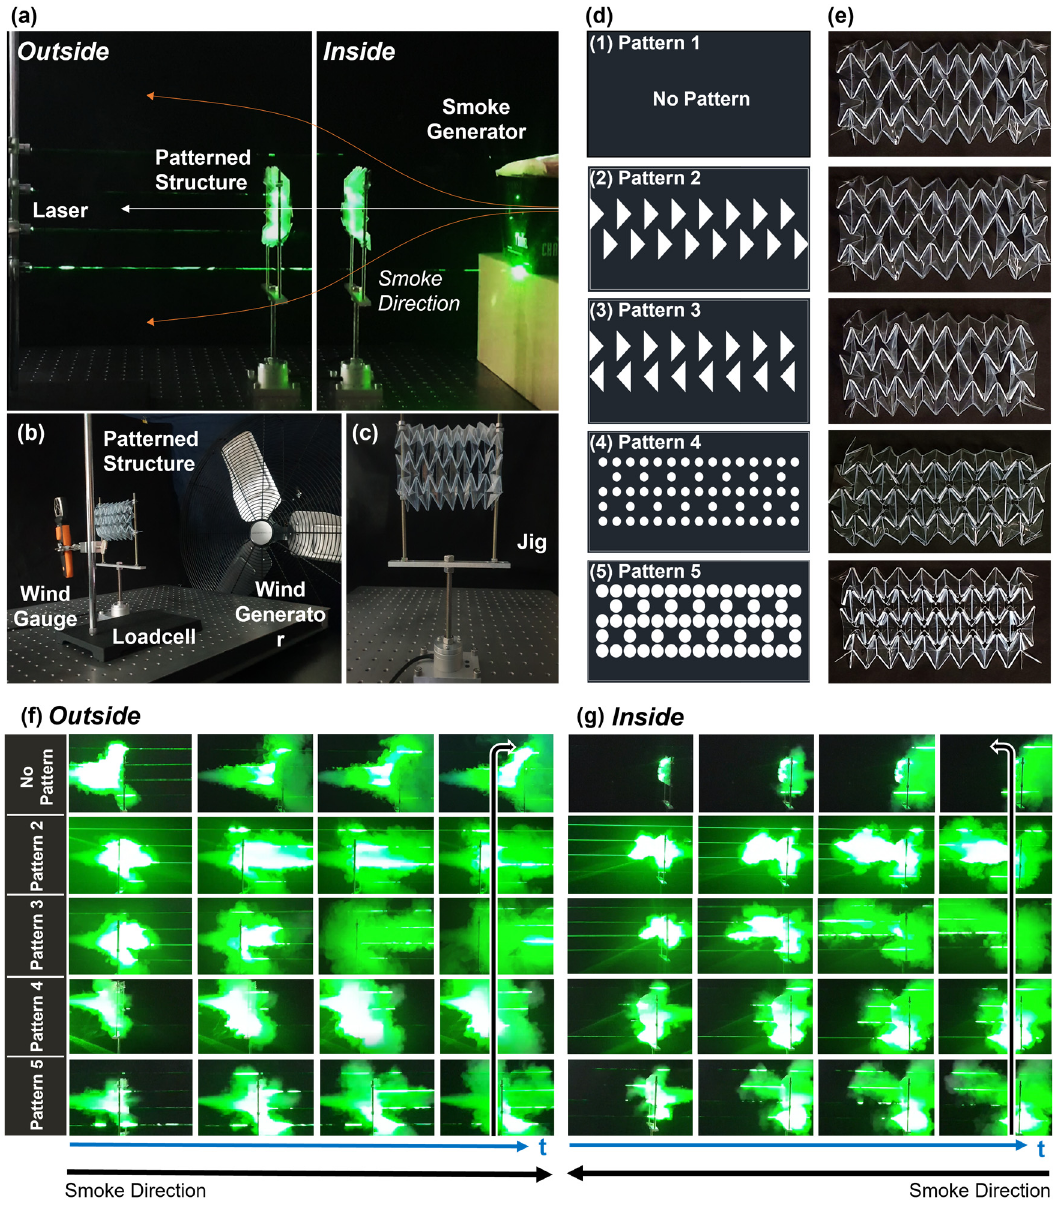
Figure 5. Air flow testing. ( a ) The flow experiment showing the laser, the smoke generator, the jig, and the origami structures with kirigami patterns. We use the terms “outside” when smoke is sprayed from the outside onto a structure, and “inside” when smoke is sprayed from the inside onto a structure. (White arrow—passing through a structure, orange arrows—spreading.) ( b ) The wind speed and load cell experimental setup. The load cell and wind speed experiments were performed in a single session. ( c ) The jig that fixes the structure to the load cell. ( d ) The kirigami patterns. ( e ) Origami structures with kirigami patterns. Flow test results; ( f ) Outer flows over time (Video S7). ( g ) Inner flows over time (Video